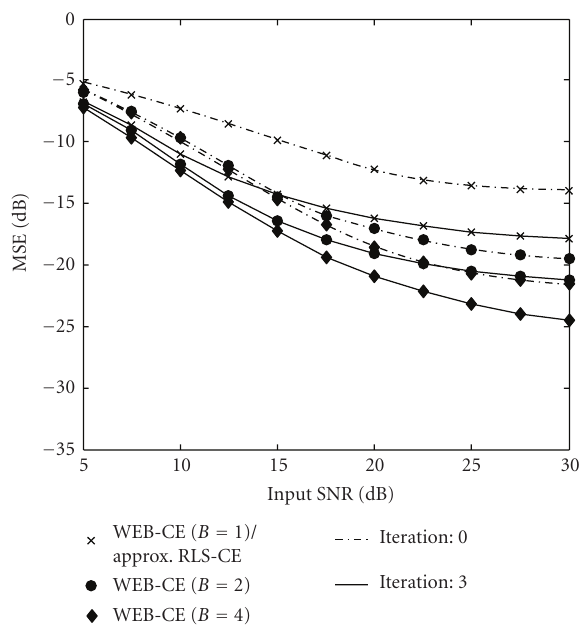
Figure 7: MSE performance of the WEB-CE ( B = 1)/approx. RLS- CE, and WEB-CE ( B = 2,4) when f d = 10 Hz.